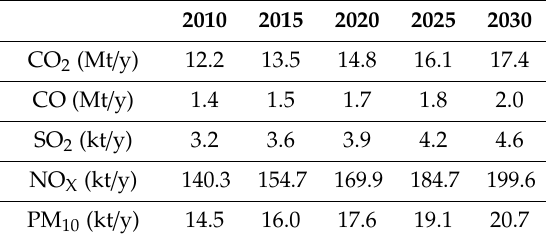
Table 5. Air pollution and GHG emissions in Tehran’s transport system 2010–2030.